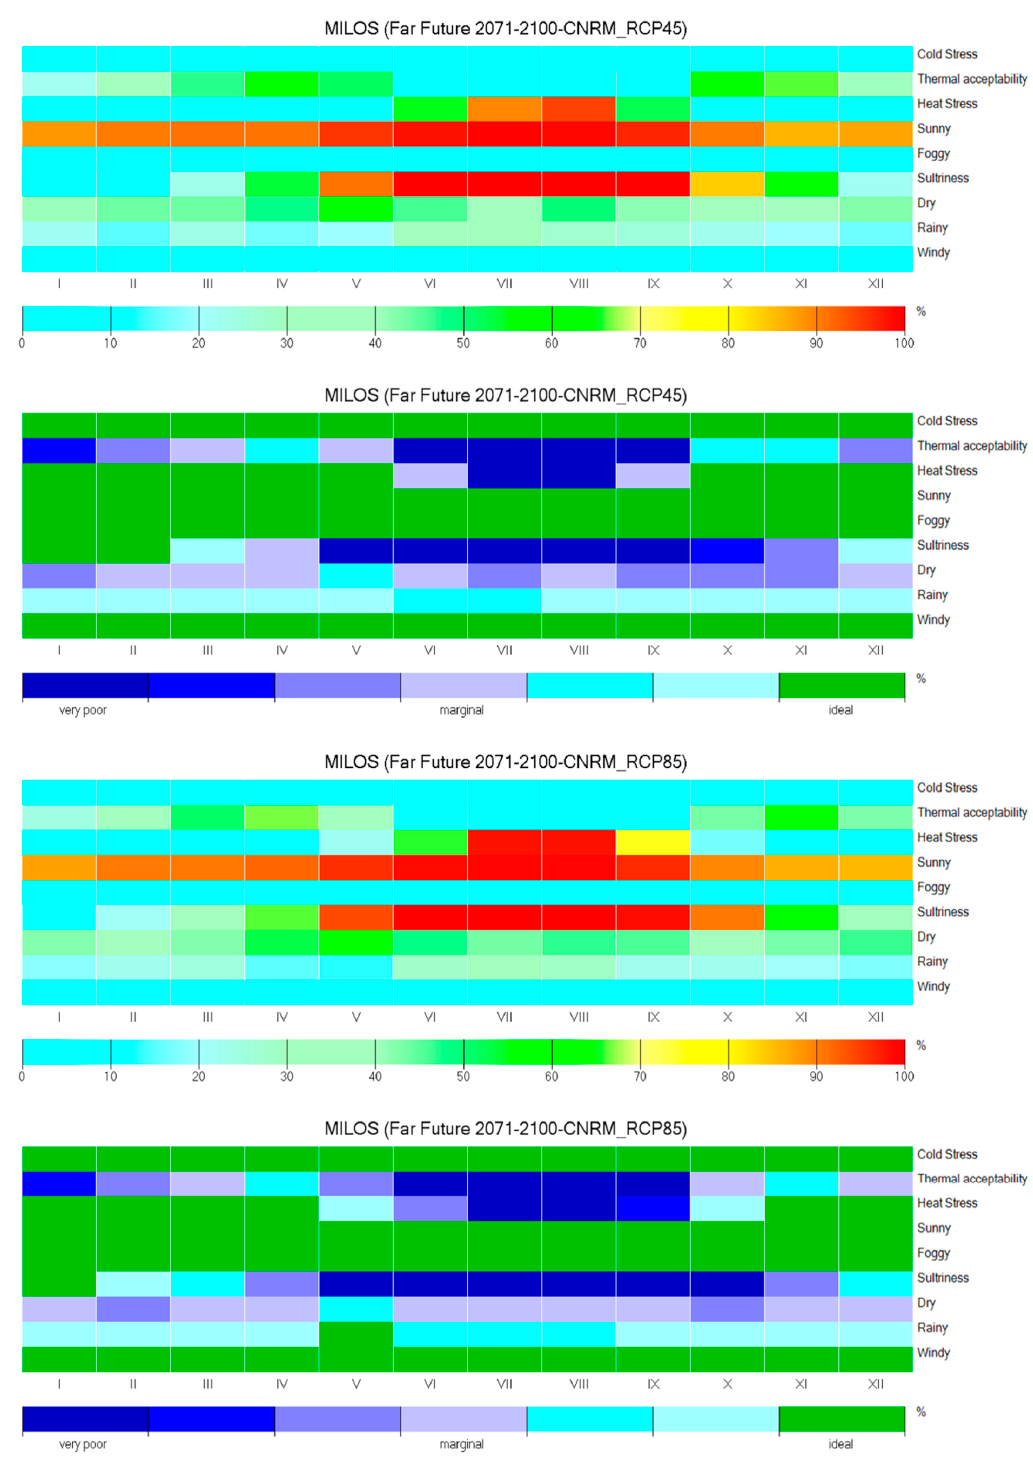
Figure 7. Climate-Tourism-Information-Scheme (CTIS), expressed by probabilities (%) and by suitability of climatic factors for Milos island for the far future 2071–2100, based on the CNRM regional climate model for two Representative Concentration Pathways, RCP4.5 (upper graphs) and RCP8.5 (lower graphs).